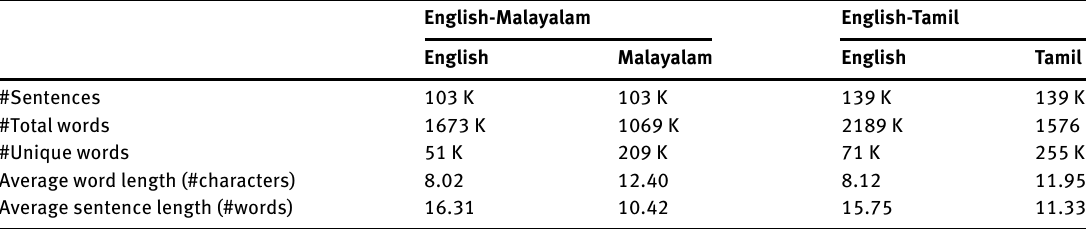
Table 2: Statistical Analysis of Morphological